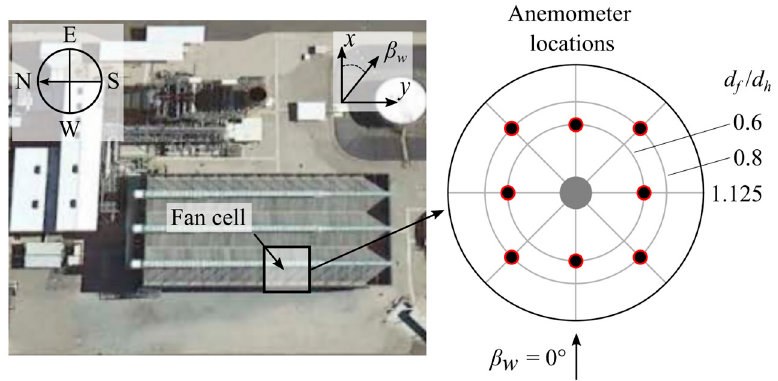
Figure 5. ACC layout and anemometer locations (adapted from [2]).